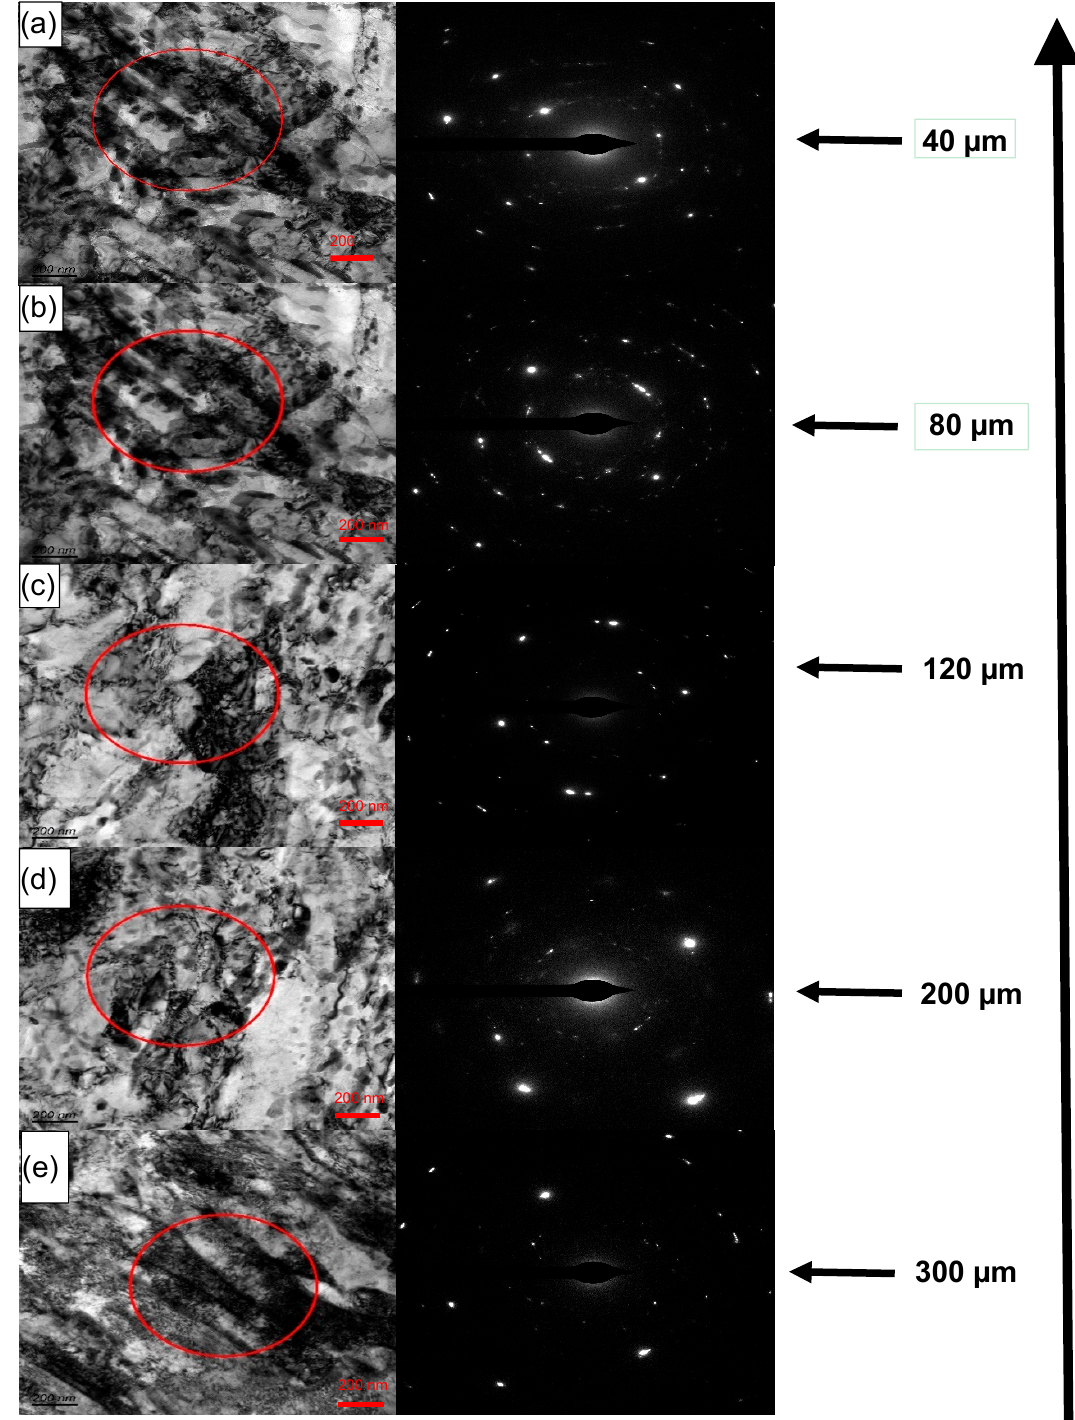
Figure 10. AWJP + USRE AISI 4340 steel TEM bright-field images and selected area electron di ff raction pattern for di ff erent depths from the sample surface. ( a ) 40 µ m from the surface; ( b ) 80 µ m from the surface; ( c ) 120 µ m from the surface; ( d ) 200 µ m from the surface; ( e ) 300 µ m from the surface.